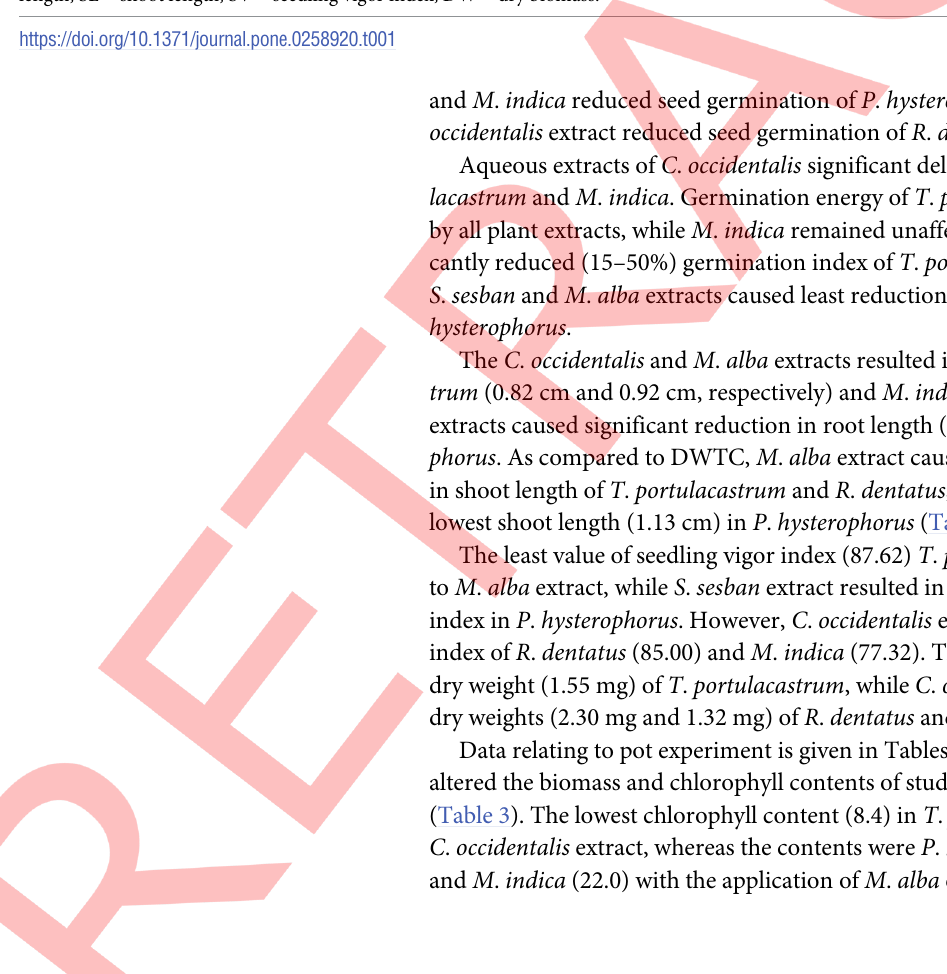
SOV = source of variation � = Significant, DF = degree of freedom, GP = germination percentage, T length, SL = shoot length, SV = seedling vigor index, DW = dry